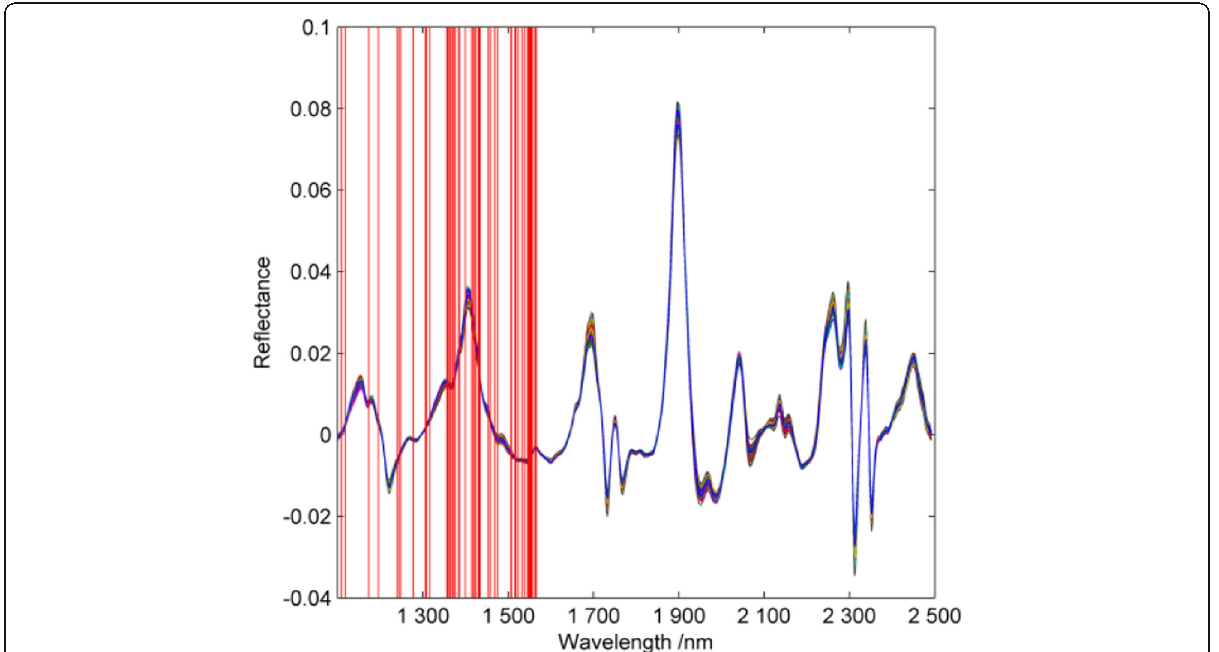
Fig. 3 Variables selected by MCUVE-SPA method. The red lines indicate variables selected by MCUVE-SPA method and a total of 49 variables were selected to develop the calibration